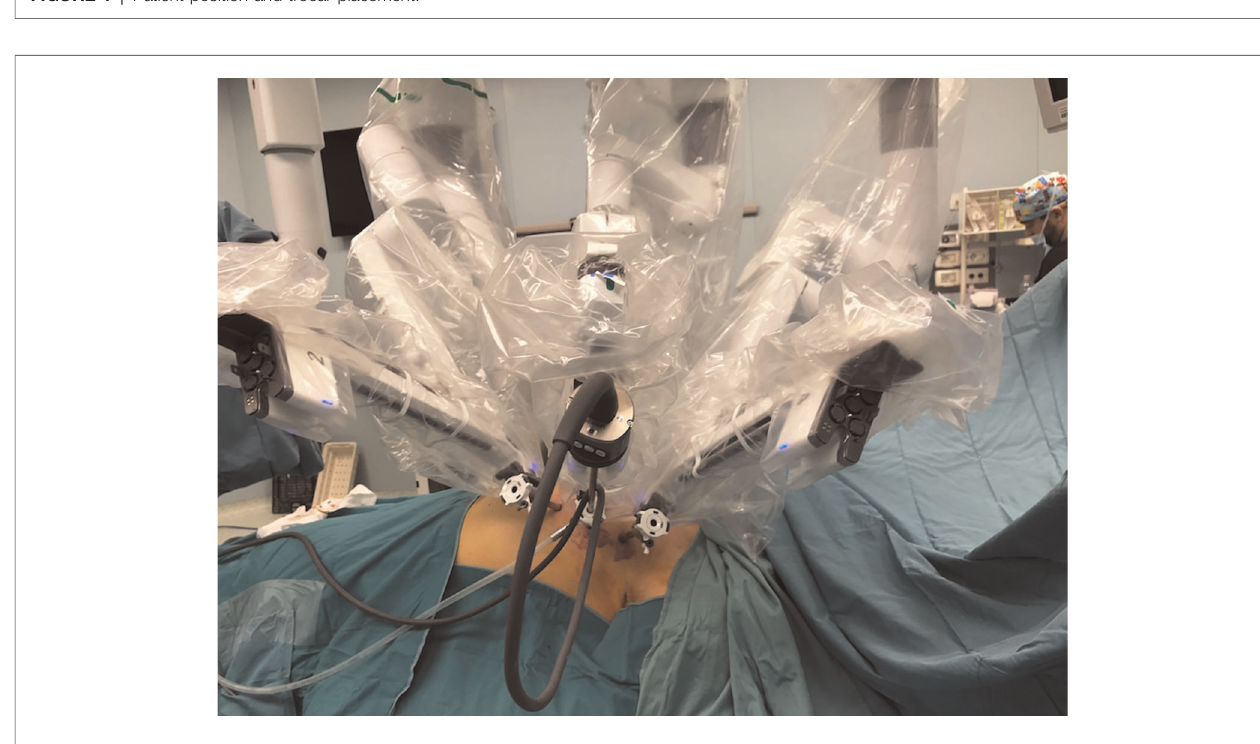
FIGURE 2 | Trocars and robotic